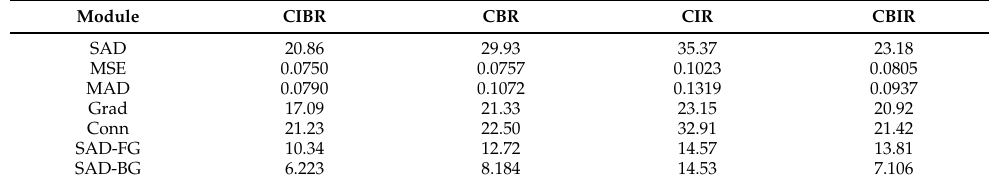
Table 4. Comparison Results Related to